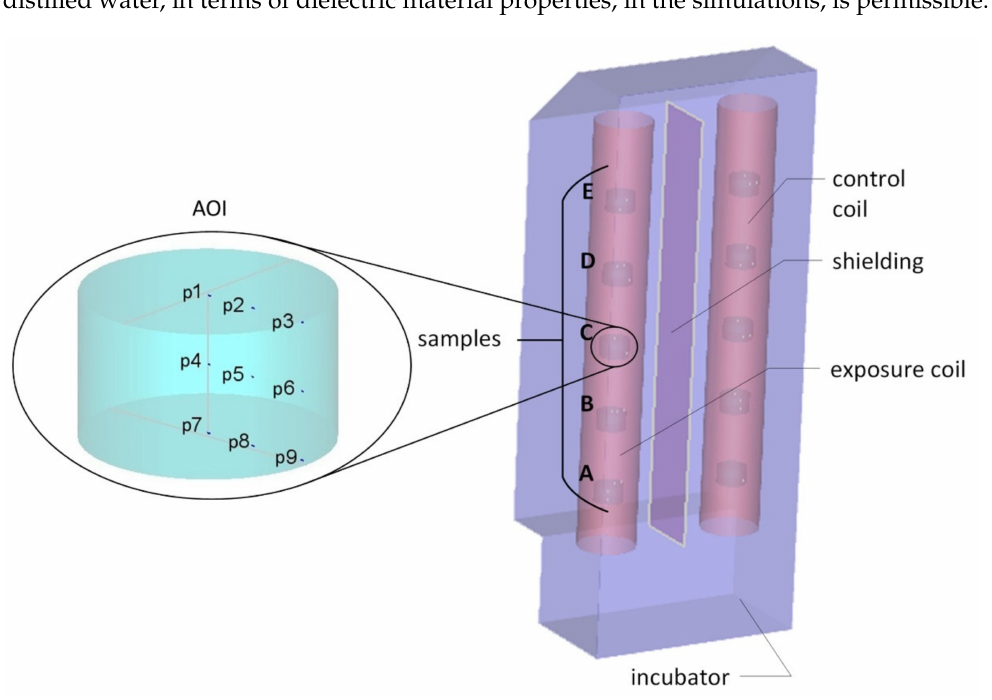
Figure 2. Components included in the numerical